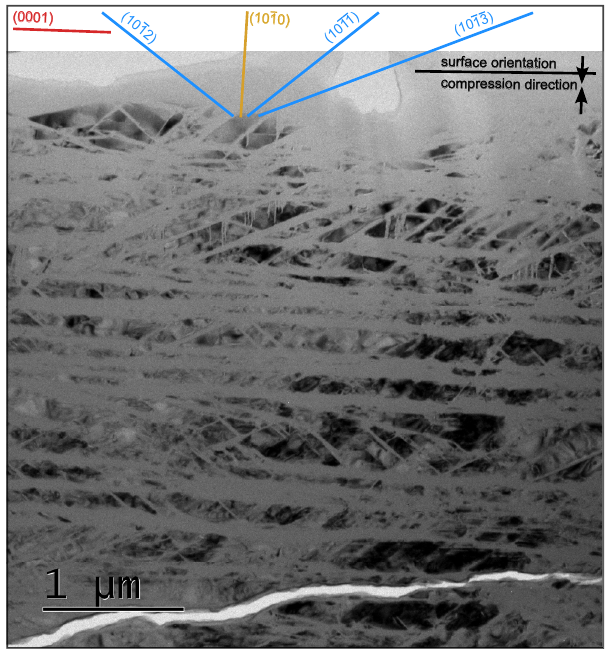
Fig.4|Bright- fi eldtransmissionelectronmicroscope(TEM)imageofrecovered quartz disc prepared by focused ion beam preparation. The image shows abundant amorphous lamellae parallel to basal, rhombohedral, and prismatic planes in quartz compressed along the c -axis (vertical in the image). The viewing direction is along the [0 (cid:1) 110] direction, i.e. vertical to the compression